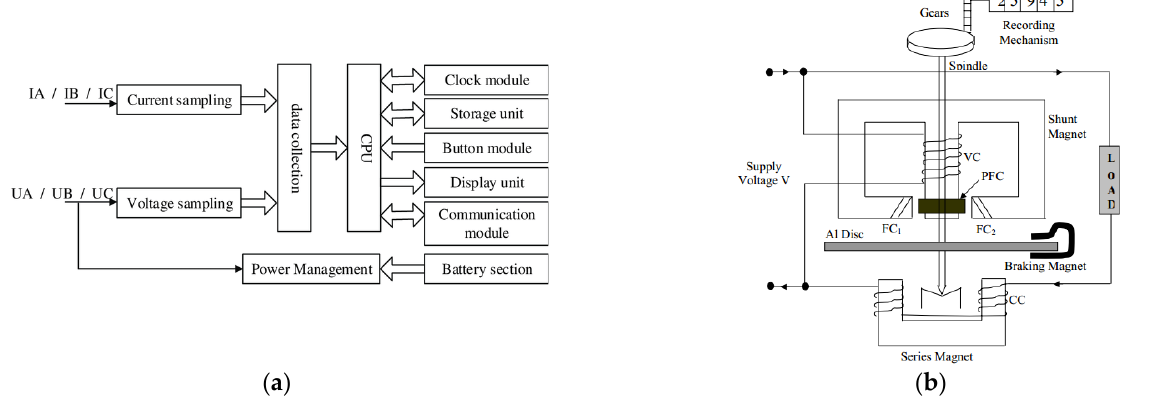
Figure 1. Construction of the energy meters: ( a ) electronic type; ( b ) electromechanical (inductive) type.